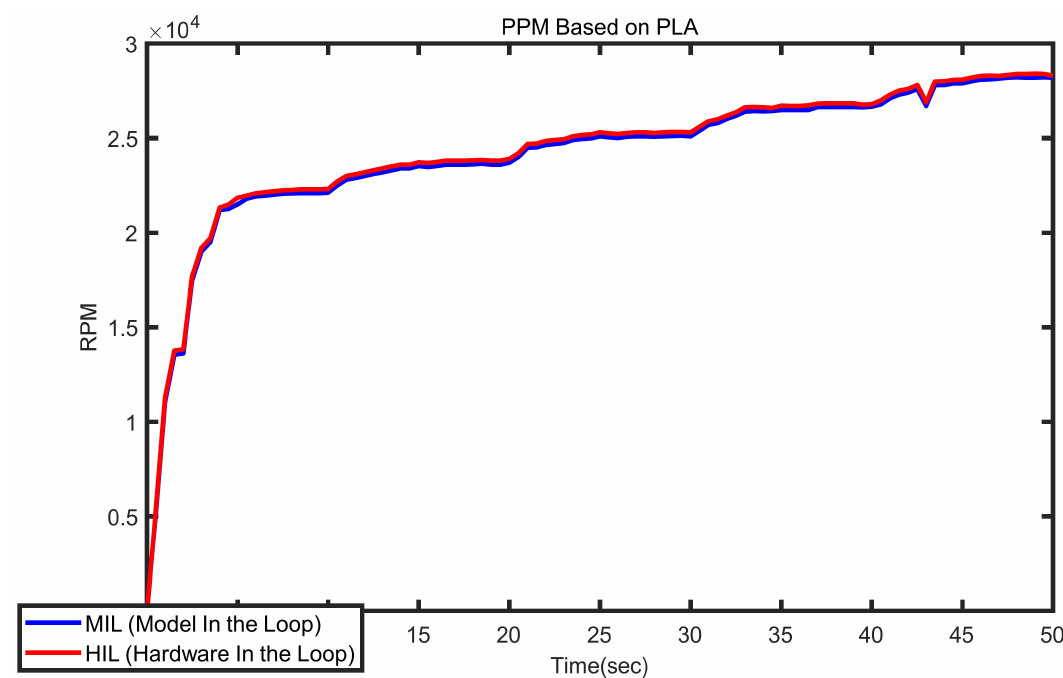
Figure 16. Model in the loop (MIL) and hardware in the loop (HIL) shaft rotational speed (RPM) signal comparison for PFC.